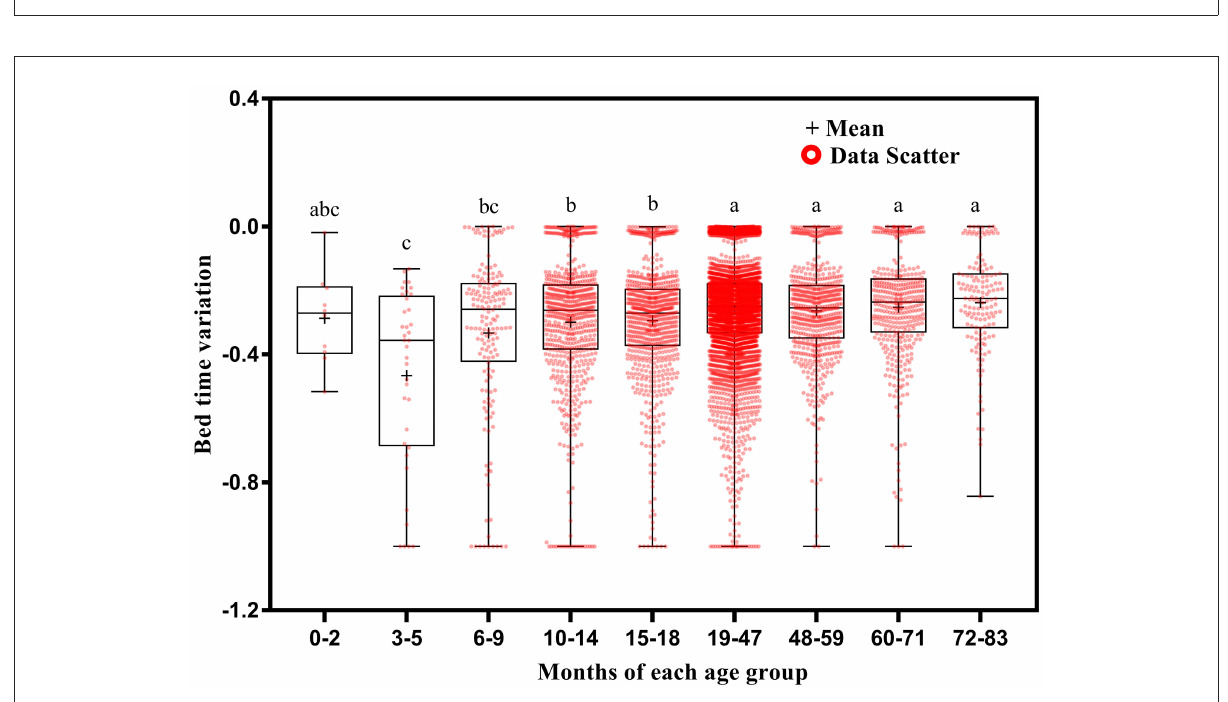
FIGURE5 Results of the one-way ANOVA for bed time variation stratified by age.